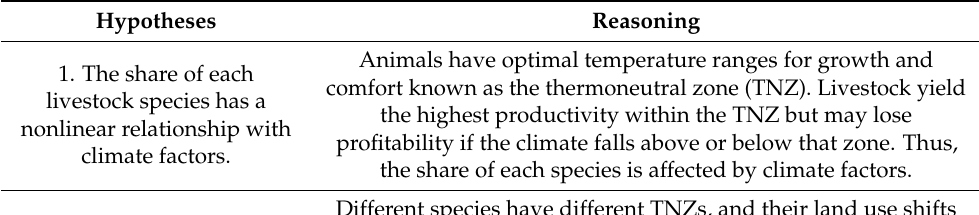
Table 1. Research